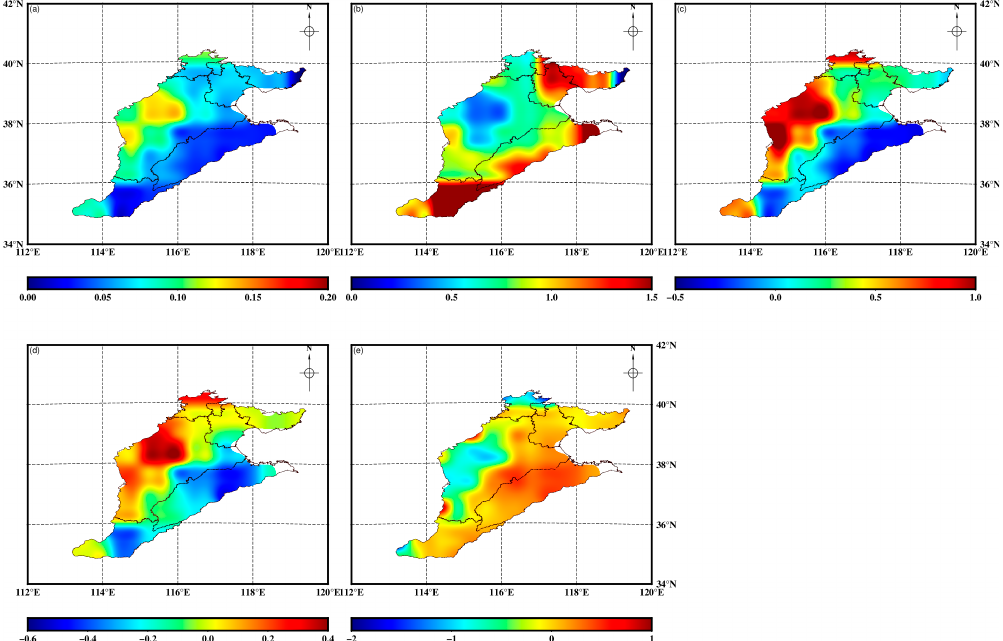
Figure 8. The special pattern of the trend in ( a ) monthly precipitation, ( b ) four-month precipitation preceding observation time, ( c ) twelve-month precipitation preceding observation time, ( d ) catchment land surface model based shallow groundwater storage, ( e ) non-climatic component of shallow groundwater storage.